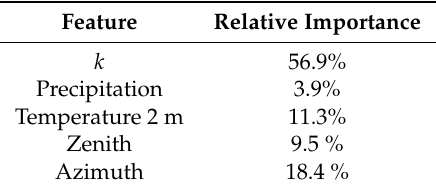
Table 3. Feature importance as the relative occurrence of the feature in the GBRT regression trees for the prediction of k pv .